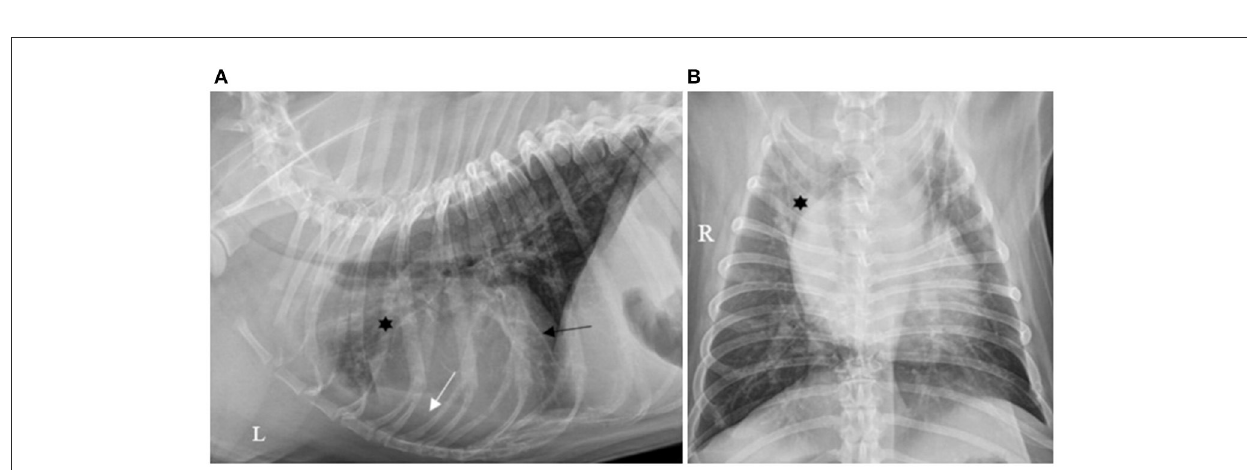
FIGURE2 (A) Left lateral and (B) ventro-dorsal thoracic X-rays of a dog with AP associated with a moderate amount of PE. An alveolar pattern is distributed ventrally in the right cranial lobe (*). A moderate amount of PE is identified by identification of a thicker fissure line (dark arrow) associated with border effacement by a fluid opacity band of the cardiac silhouette ventrally (white arrow). AP, aspiration pneumonia; PE, pleural effusion (source: medical imaging department of the veterinary university clinic of Liege,